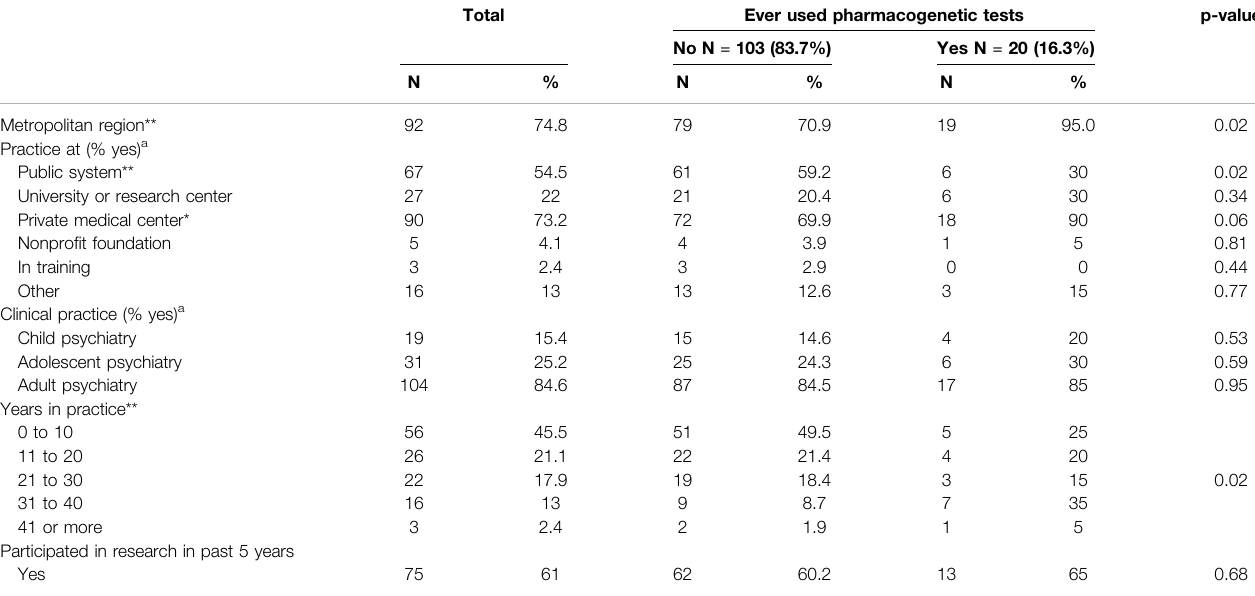
TABLE 1 | Sample characteristics and associations with prior use of PGx